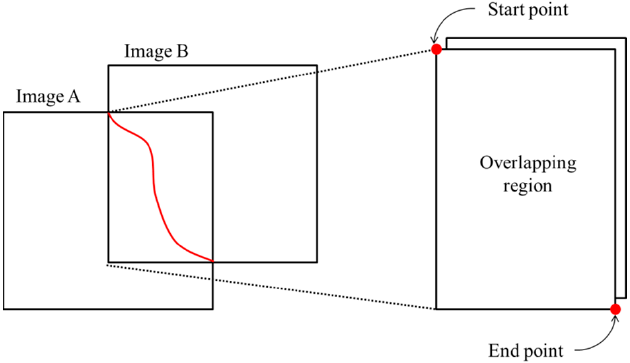
Figure 4. Determining overlapping region and start/end point.